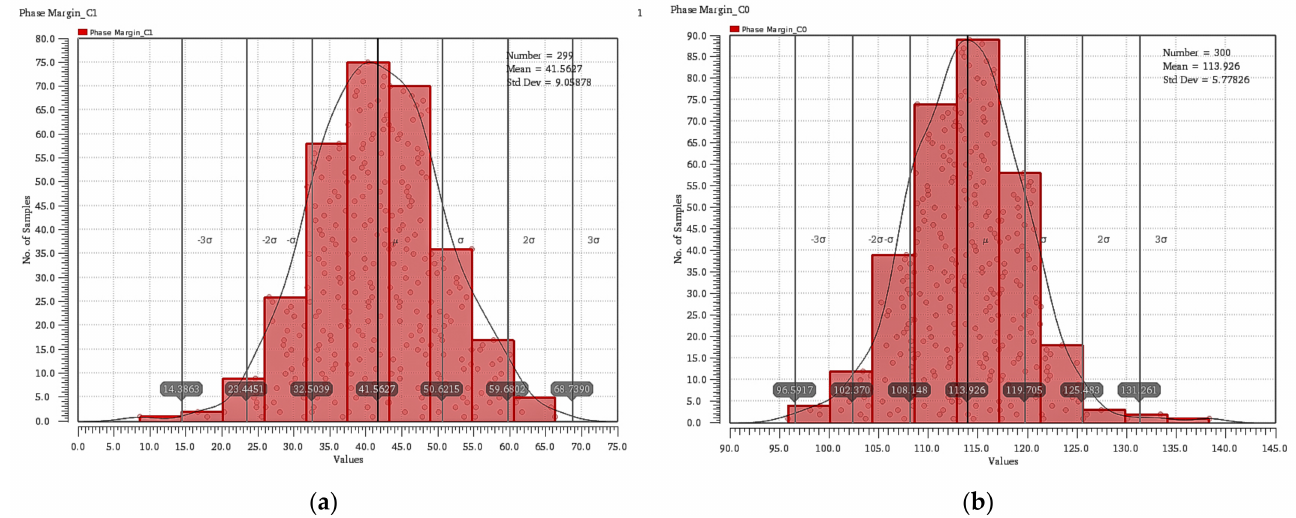
Figure 9. ( a ) Monte Carlo simulation results of the phase margin with I load = 10 µ A and C L = 100 pF; ( b ) Monte Carlo simulation results of the phase margin with I load = 100 mA and C L = 100